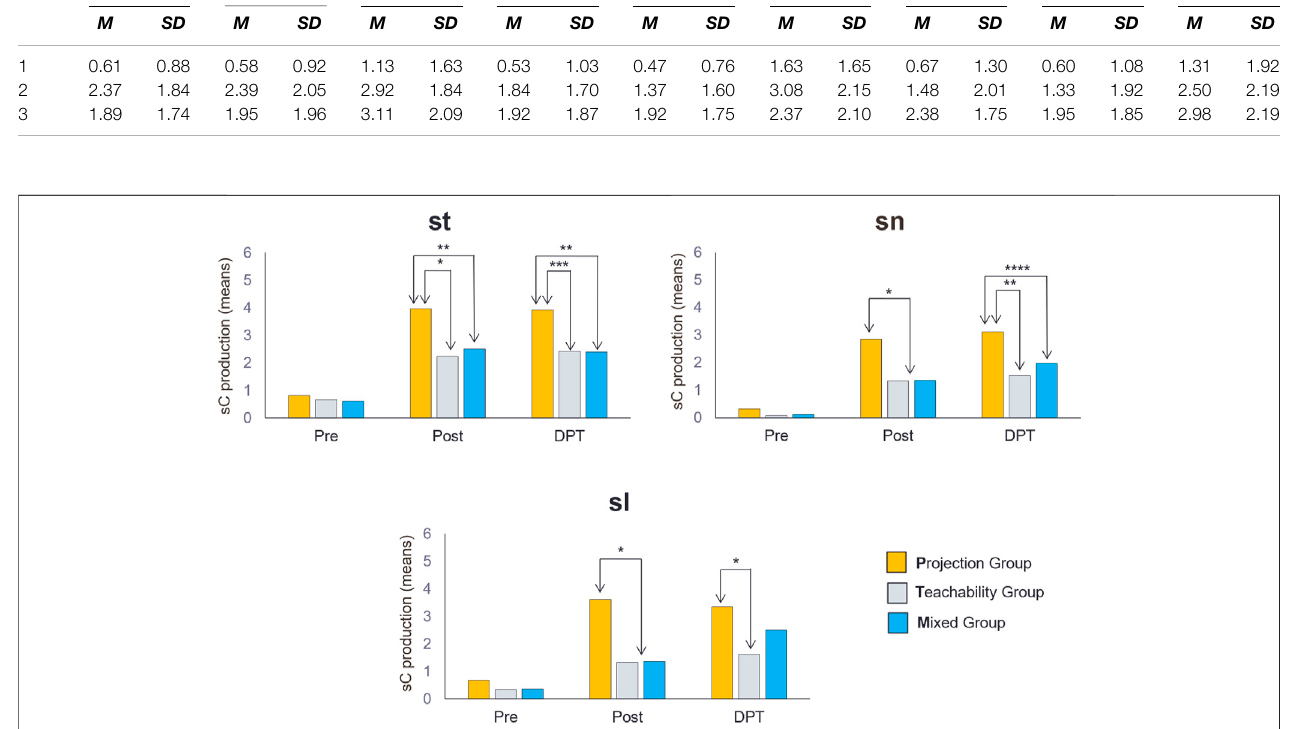
FIGURE 2 | Group Means on Read Aloud Test Over Time. Note. Signi fi cance: * p < 0.001; ** p (cid:1) 0.002; *** p (cid:1) 0.003; **** p (cid:1) 0.040.